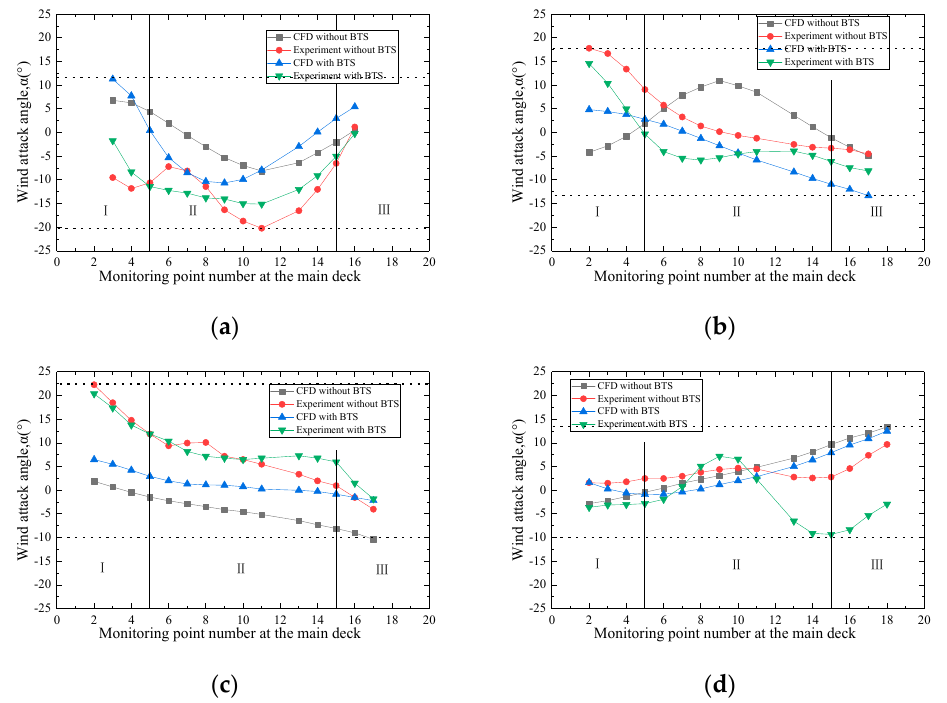
Figure 15. Wind attack angle at main deck level of wind tunnel tests and CFD simulation. ( a ) Case 1; ( b ) Case 2; ( c ) Case 3; ( d ) Case 4. ( b ) Case 2; ( c ) Case 3; ( d ) Case